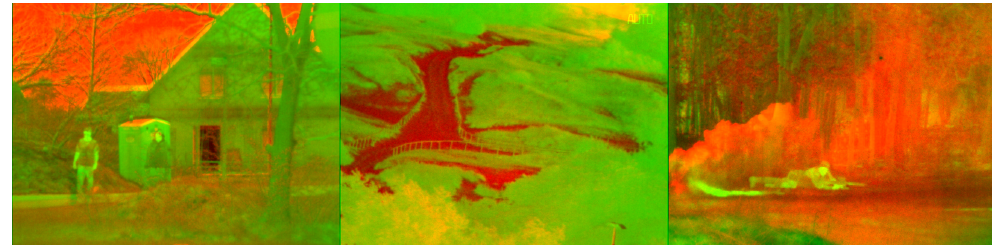
Figure 13. Some images from the TNO dataset [40].